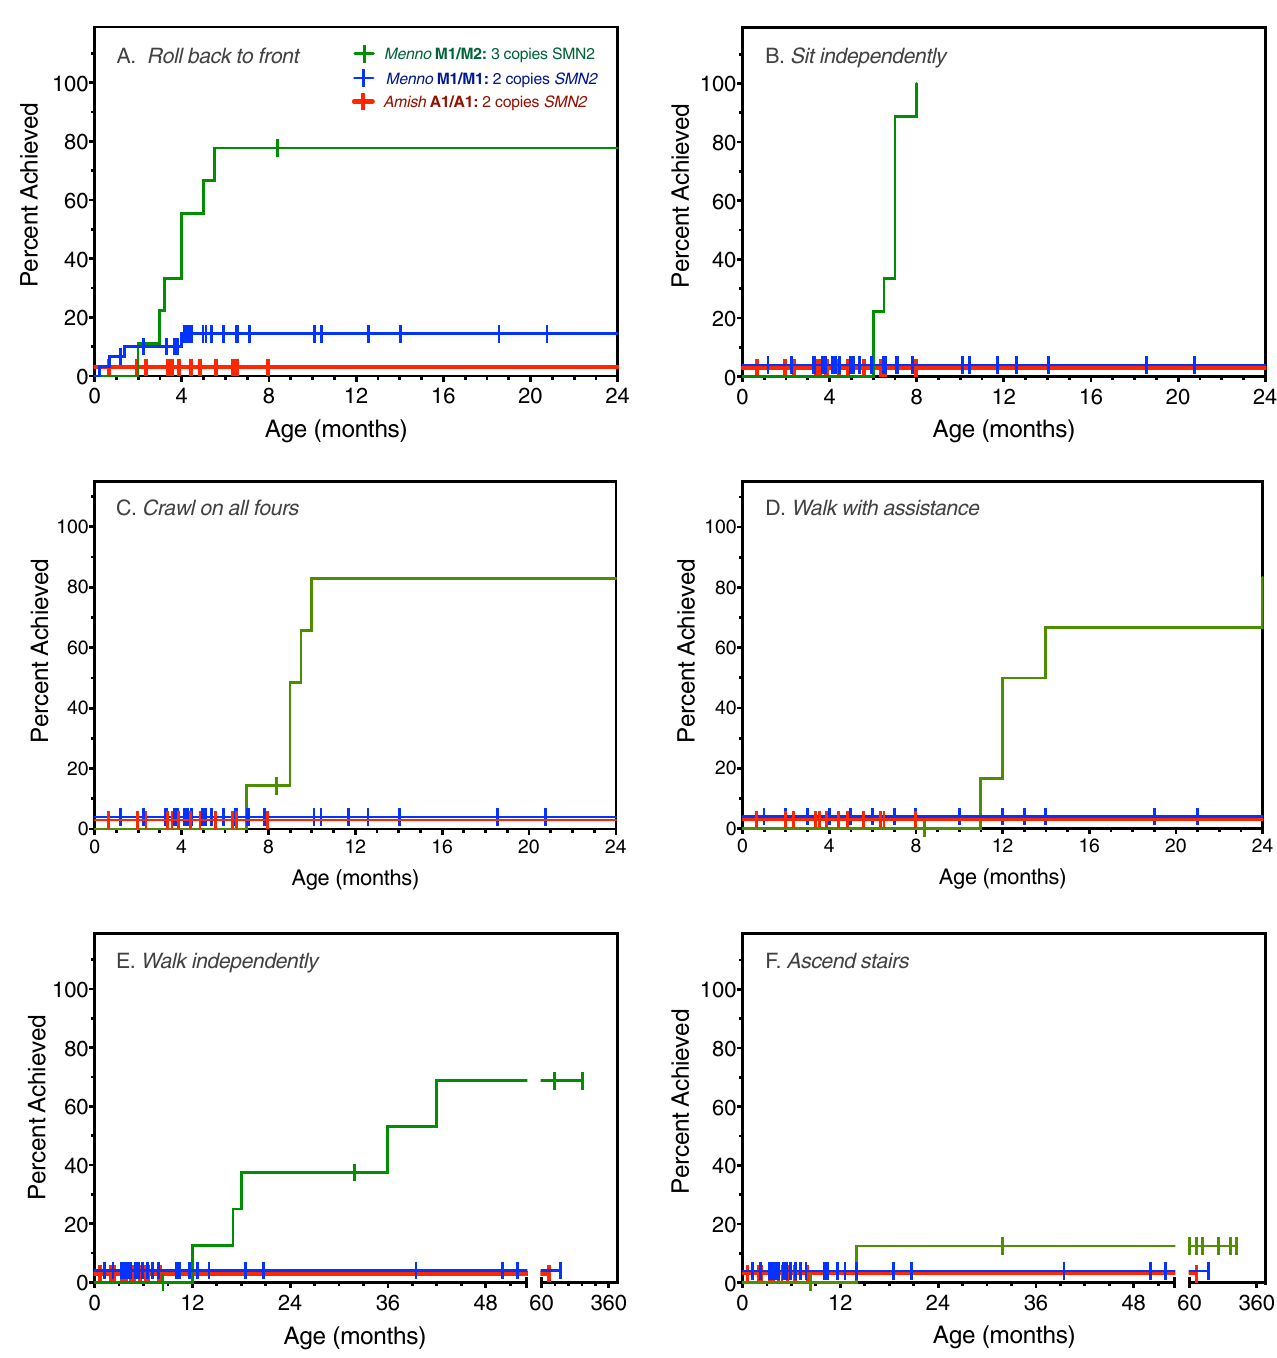
Fig 5. Motor milestone acquisition and SMN2 copy number. Time to motor milestone acquisition is plotted for Mennonite (blue; M1/M1, n = 30) and Amish (red; A1/A1, n = 14) patients harboring 2 copies of SMN2 as compared to Mennonites with 3 copies of SMN2 (green; M1/M2, n = 9). Perpendicular symbols indicate subjects unable to achieve a skill at the time of census (or death). Milestones depicted include rolling back to front (A), independent sitting (B), crawling on all fours (C), walking with assistance (D), independent walking (E), and ascending stairs (F). One child with 3 copies of SMN2 walked and ascended stairs at 12 and 14 months of age, respectively. Note the divided X-axis in panels E and